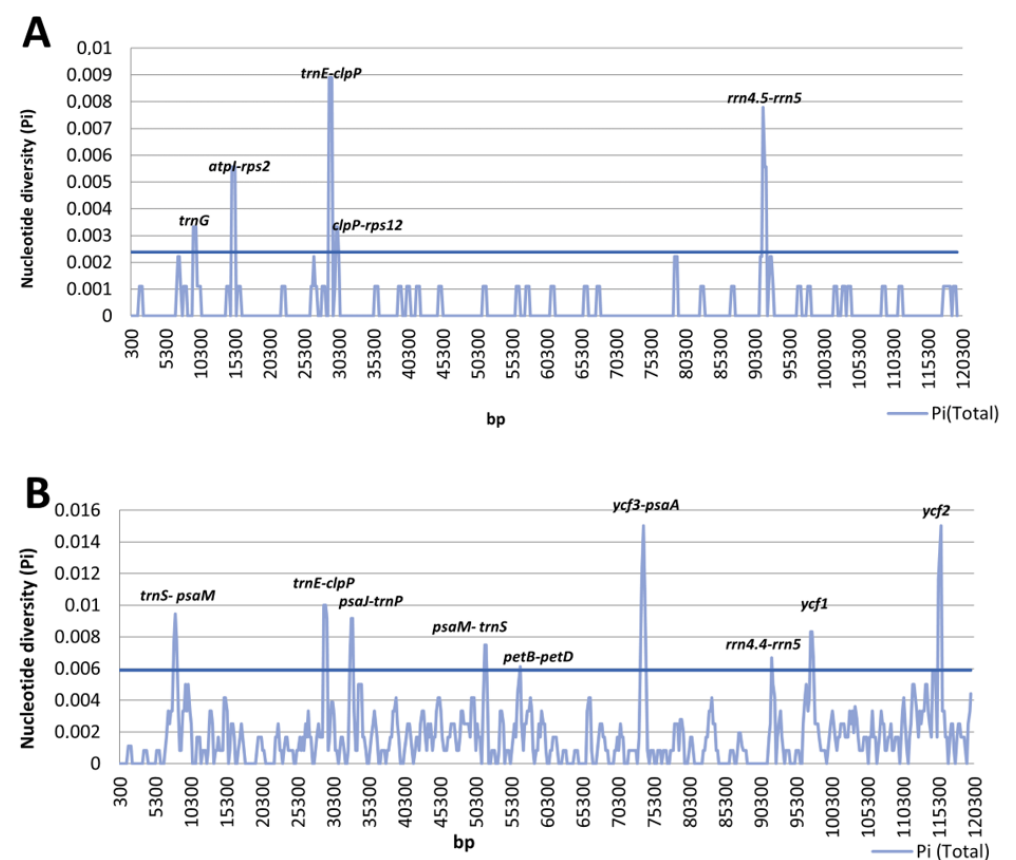
Figure 3. Sliding window analysis of the whole chloroplast genomes. Window length: 600 bp; step size: 200 bp. X-axis: position of the midpoint of a window. Y-axis: nucleotide diversity of each window. ( A ) Pi between three the Pinus mugo complex representatives. ( B ) Pi among the Pinus mugo complex representatives and Pinus sylvestris . The horizontal line on the graph sets the threshold separately for the Pinus mugo complex representatives (0.00238) and separately for the Pinus mugo complex representatives and Pinus sylvestris (0.00589).